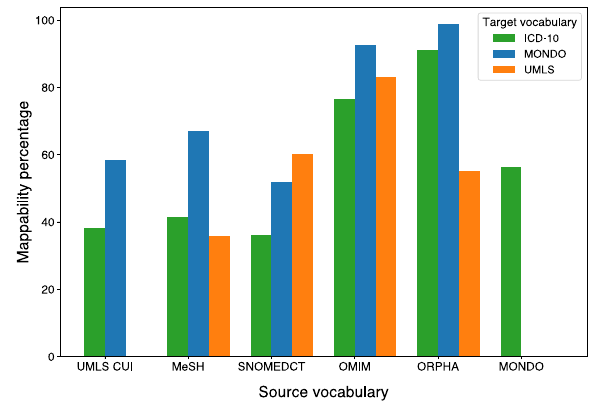
Fig.7| Levelsofcompletenessofdiseasevocabularymappingsunderlyingthis article. For each source-target vocabulary pair, mappability is computed as the percentage of terms in the source vocabulary used in this study that could be mapped to a term in the target vocabulary.